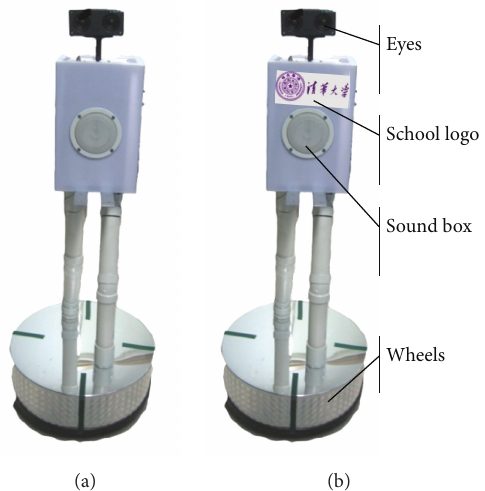
Figure 1: The robot used in the study ((a) outgroup; (b)